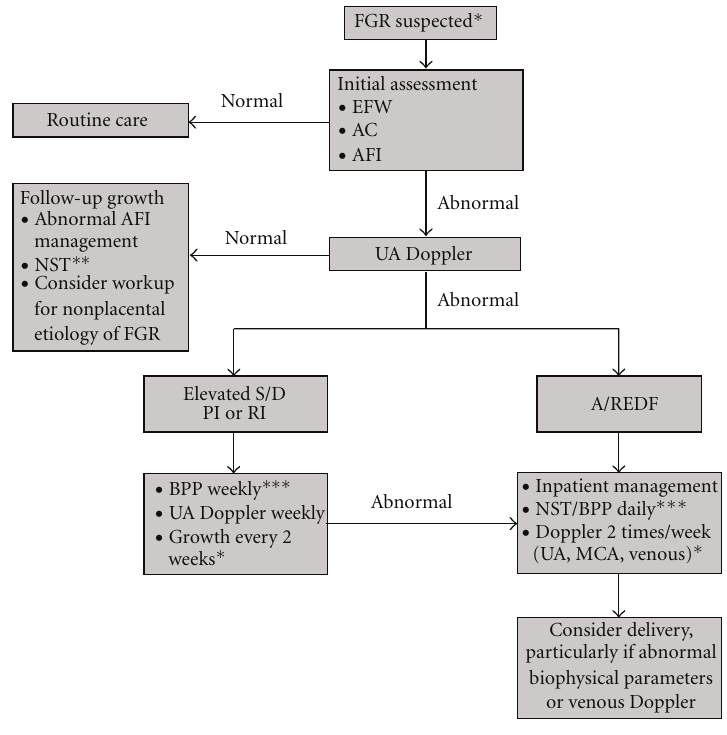
Figure 2: A proposed monitoring scheme in pregnancies complicated by FGR. This figure focuses on FGR associated with placental dysfunction. See text for additional